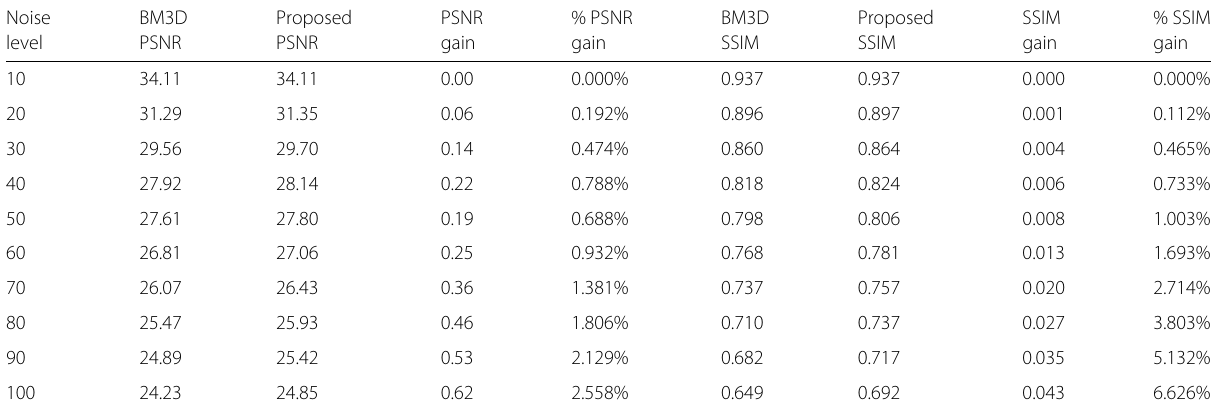
Table 4 Performance comparison of color profile (normal) and proposed method Noise